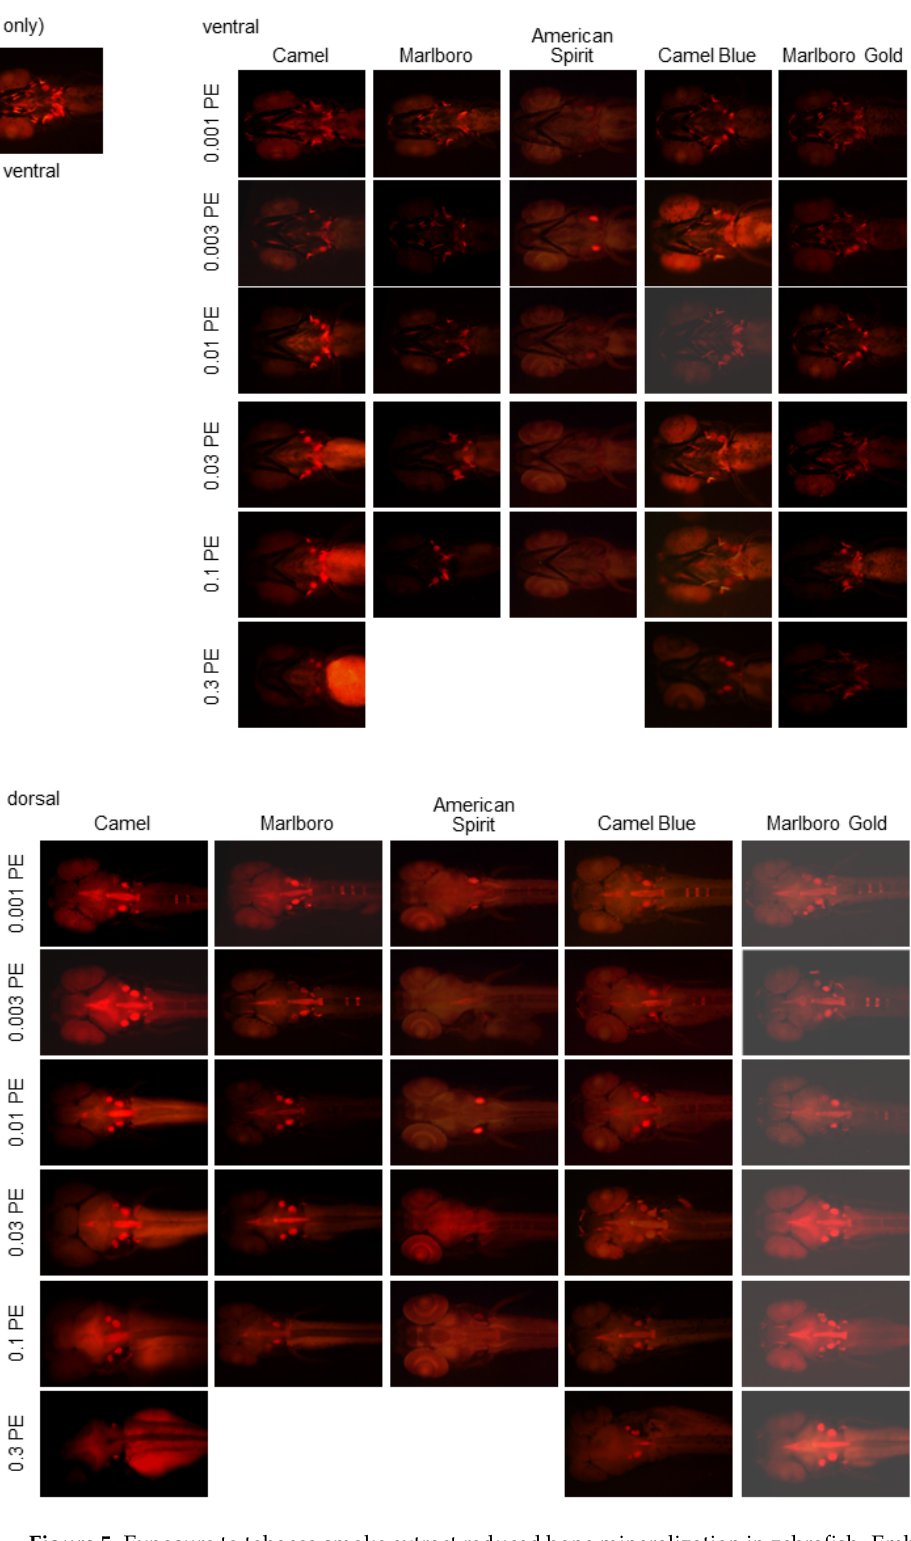
Figure 5. Exposure to tobacco smoke extract reduced bone mineralization in zebrafish. Embryos were placed in a tobacco-smoke-extract-containing E3 embryo media at 5 hpf, then collected, fixed, and stained with Alizarin Red S at 6 dpf. Representative images of Alizarin Red S staining assessed with a fluorescence microscope and a 532 nm filter from zebrafish larvae treated with Camel, Marlboro, American Spirit, Camel Blue, and Marlboro Gold sidestream smoke at the indicated concentrations in puff equivalents (PE) are